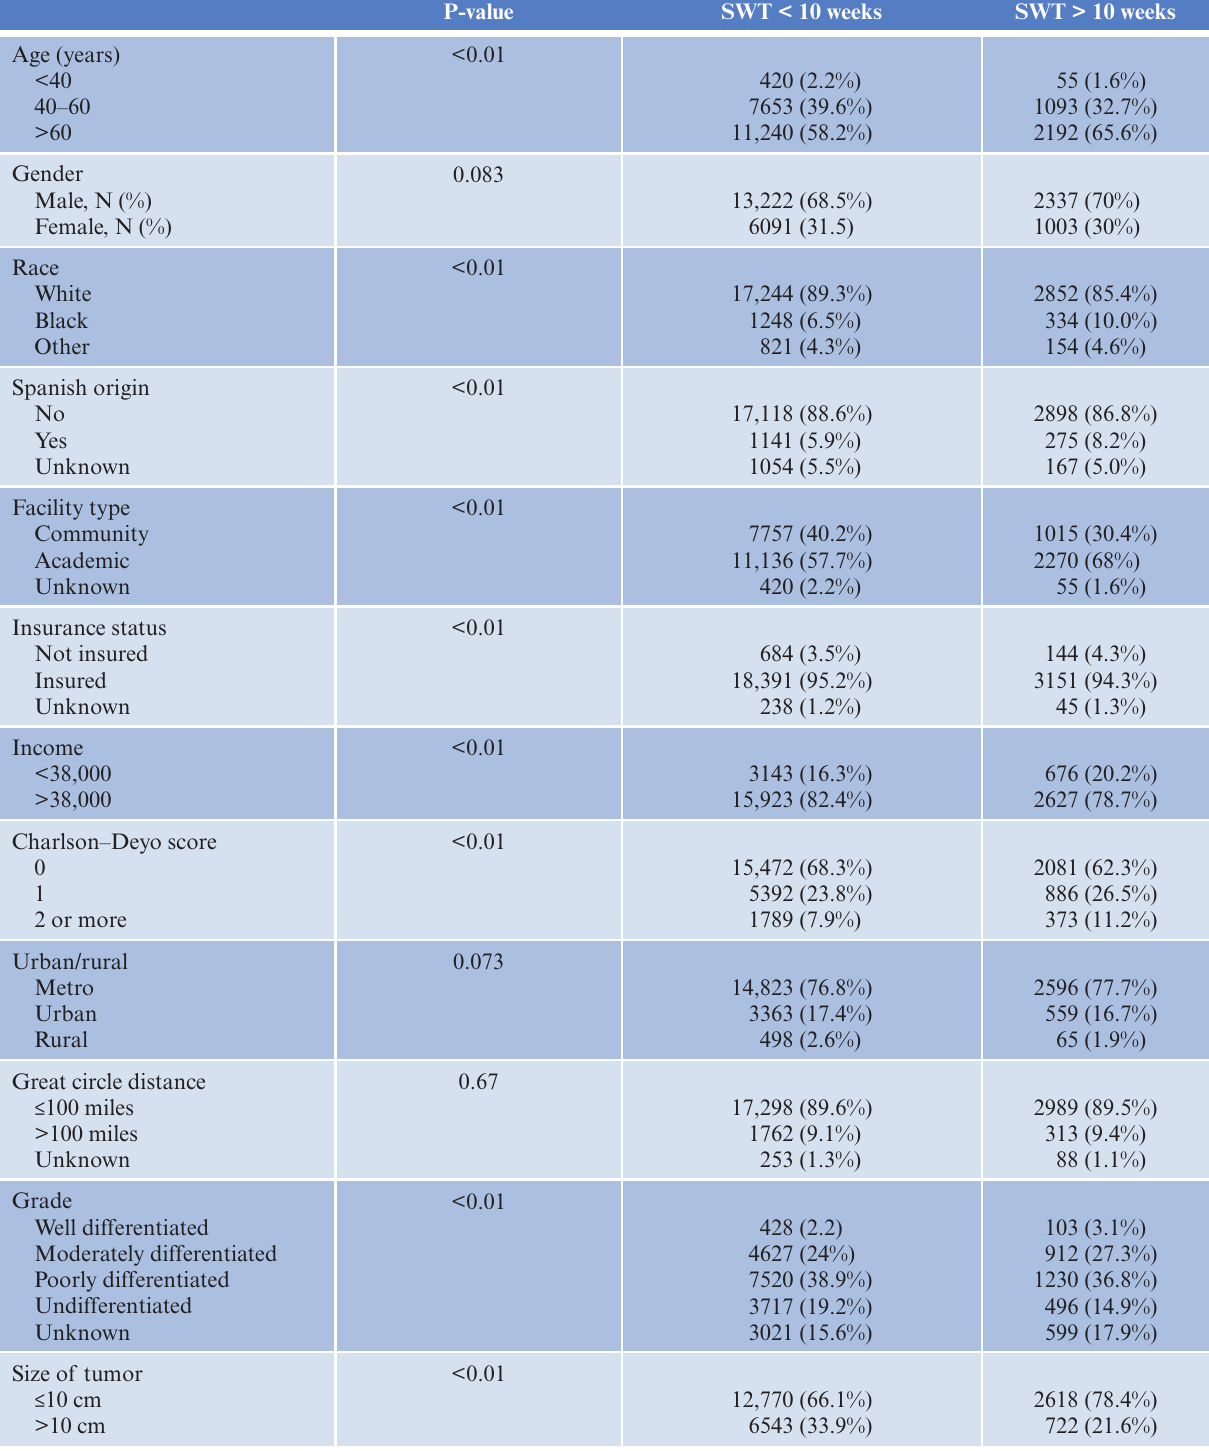
Table 1: Patient demographics and tumor characteristics. P-value SWT < 10 weeks SWT > 10